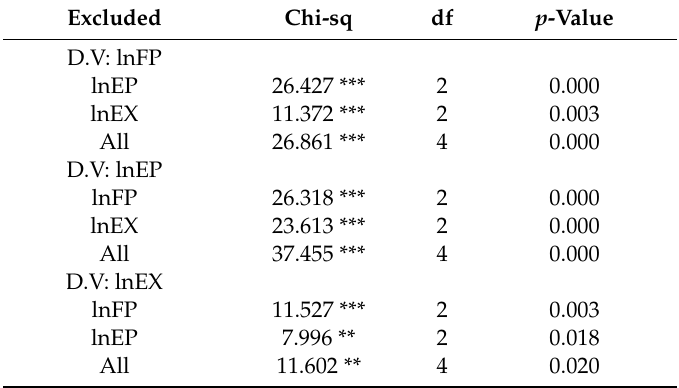
Table 6. Granger causality Wald test.